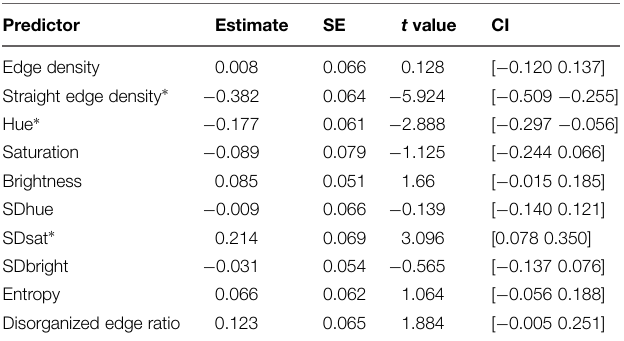
TABLE 1 | Results of regressing esthetic preference on image